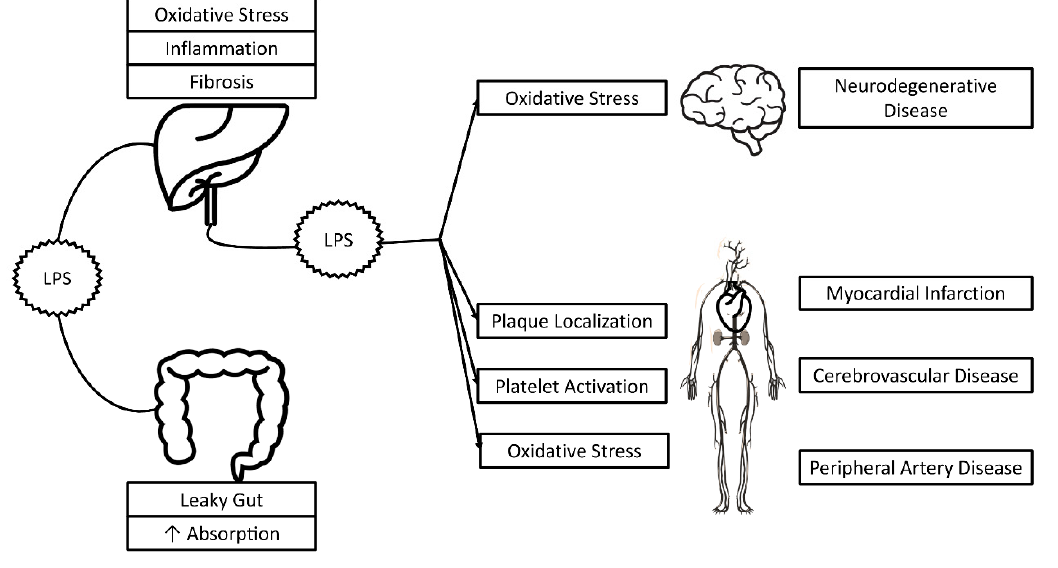
Figure 2. Possible effects of LPS in non-alcoholic fatty liver disease and non-hepatic disorders.